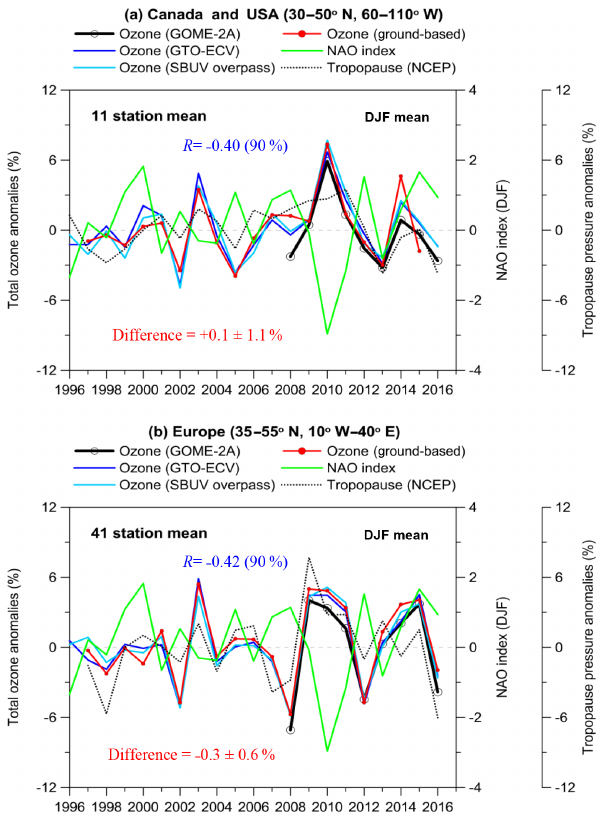
Figure 12. Comparison with GB observations over (a) Canada and USA and (b) Europe in winter (DJF mean). R is the correlation coefficient between GTO-ECV total ozone and the NAO index. The differences refer to the mean differences ± σ (in %) between GTO- ECV and GB data.